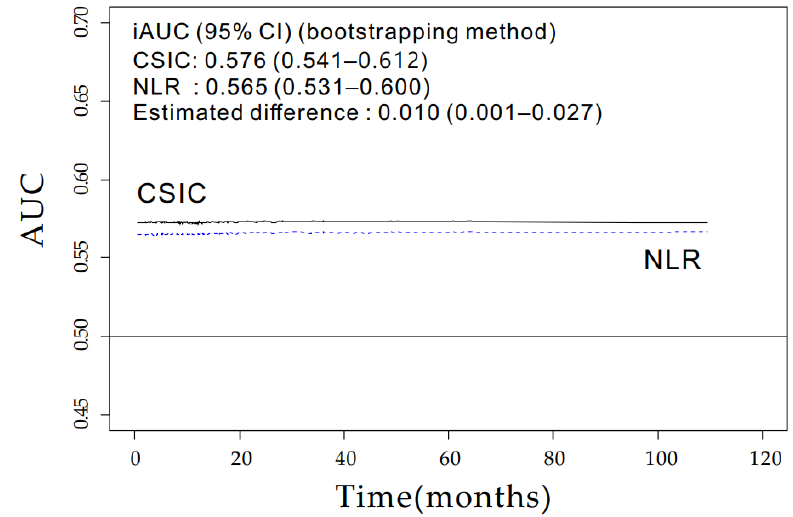
Figure 2. Time-dependent area under the curve (AUC) plot for comparing the prognostic accuracy of the combined sarcopenia and inflammation classification (CSIC; solid line) and neutrophil-to- lymphocyte ratio (NLR; dashed line). Bootstrap iAUC mean values of CSIC and NLR are 0.576 (95% CI, 0.541–0.612) and 0.565 (95% CI, 0.531–0.600), respectively. The increased integrated AUC (iAUC) of CSIC when compared with NLR represents the superior prognostic accuracy of CSIC (bootstrap iAUC mean difference = 0.010; 95% CI, 0.001–0.027).